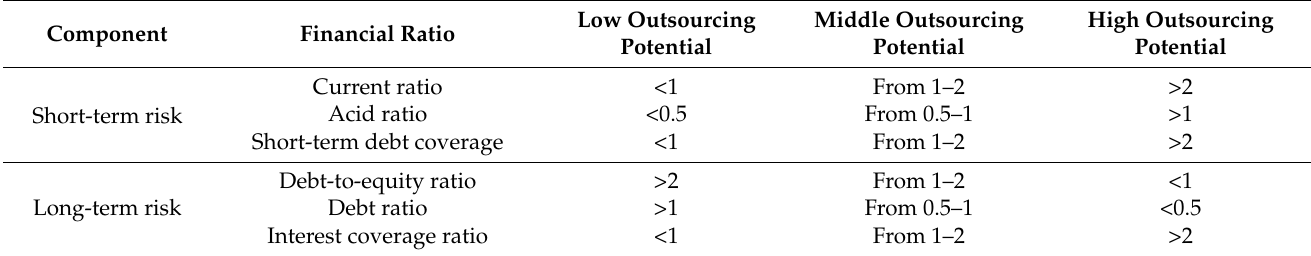
Table 4. Short- and long-term risk benchmarking indicators for classification of